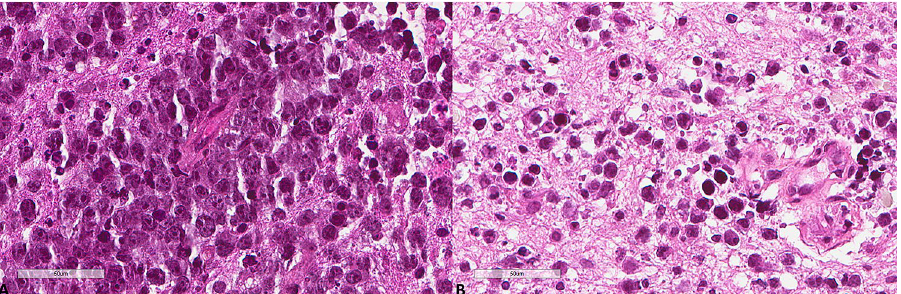
Figure 4. Representative morphological images. ( A ) Hematoxylin, eosin, safran section of the PCNSL shown in Fig. 3A (× 400). ( B ) Hematoxylin, eosin, safran section of the PCNSL shown in Fig. 3B (×